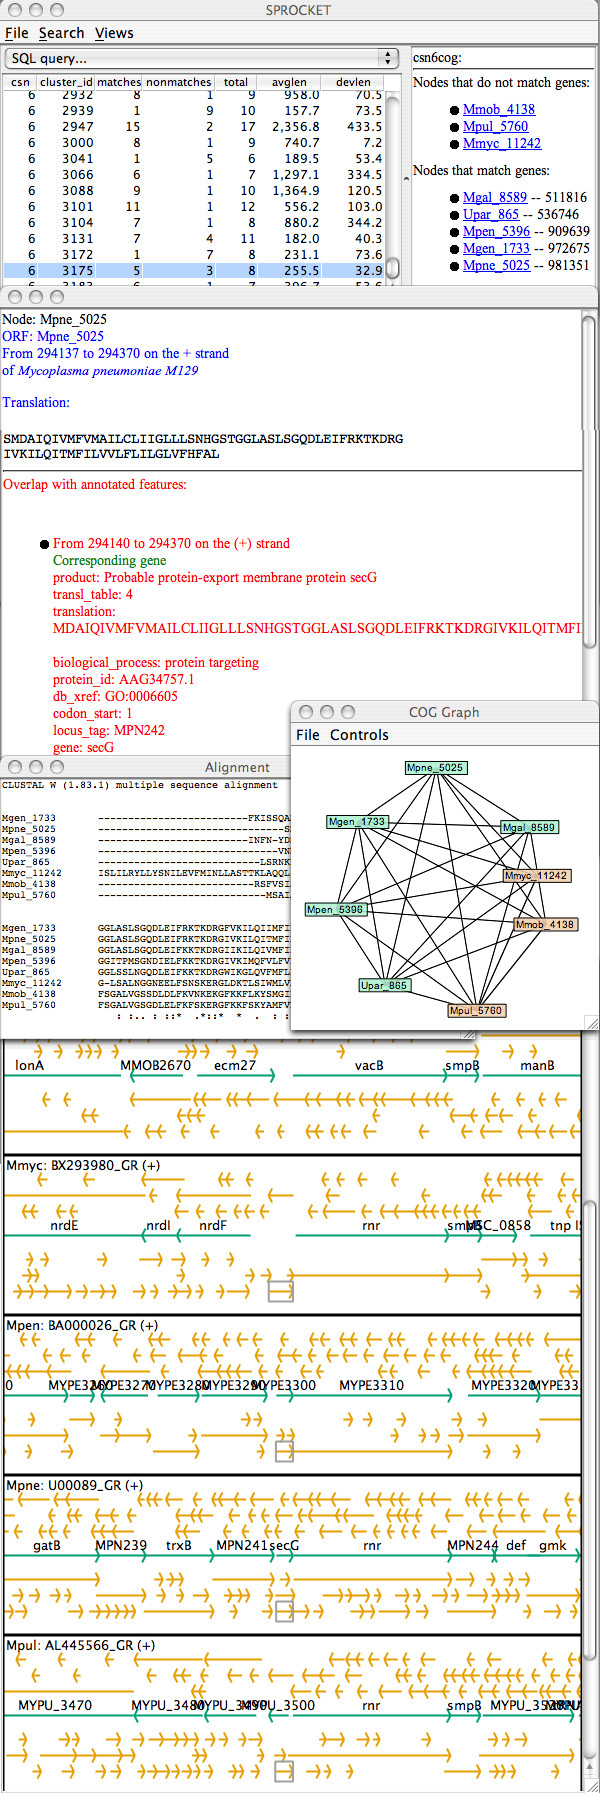
SPROCKET. The SPROCKET program was developed to facilitate the analysis performed in this study. For the members of a COG, a user can view the peptide sequence alignment (using CLUSTALW), a graph of the best-hit relationships and the genomic context.